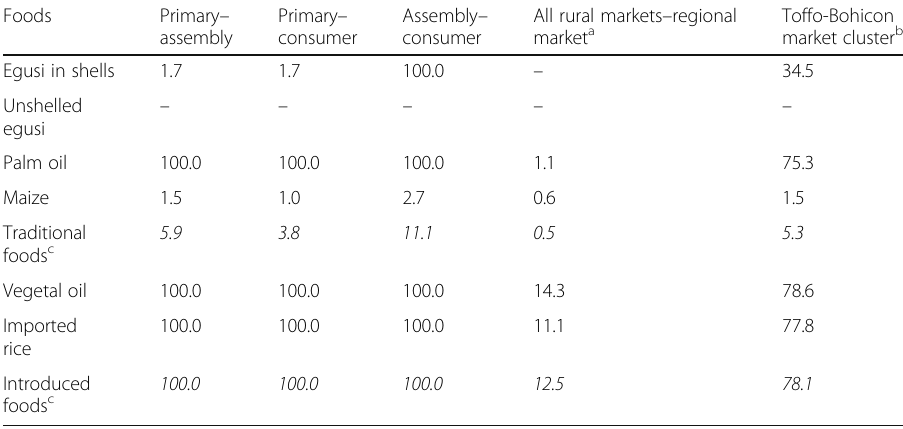
Table 5 Price instability-based market integration indicator ( G ) in Toffo-Bohicon market cluster